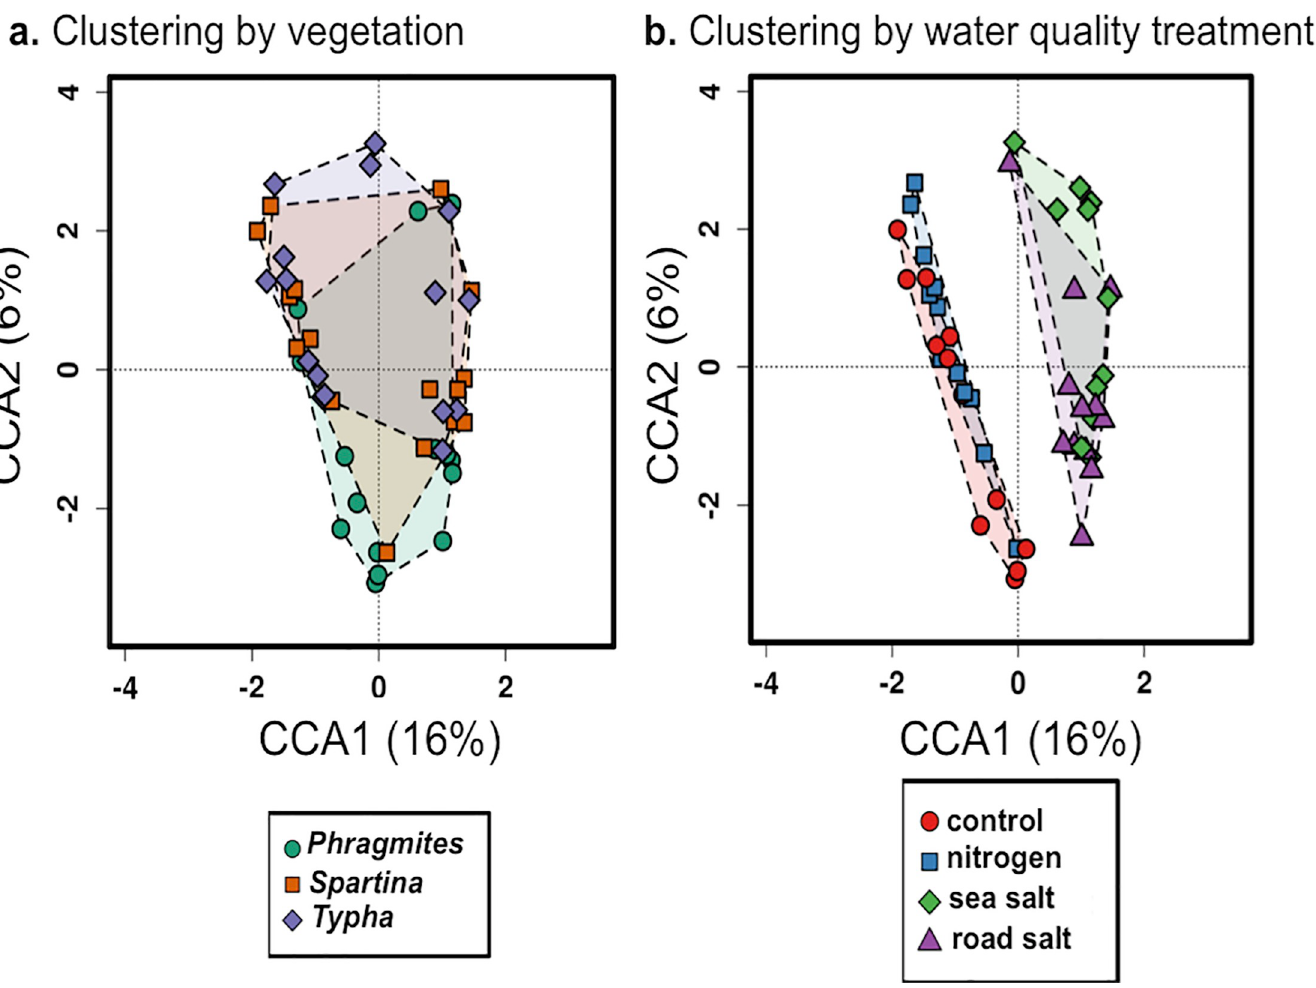
Fig 5. CCA-clustering of bacterial 16S rRNA gene datasets. (a) Data clustered by vegetation type. Significance of clustering was tested with the permutation anova CCA test and vegetation was a significant factor for clustering (p = 0.005). (b) The same data clustered by water quality treatment, which was also a significant factor in dataset clustering (p =